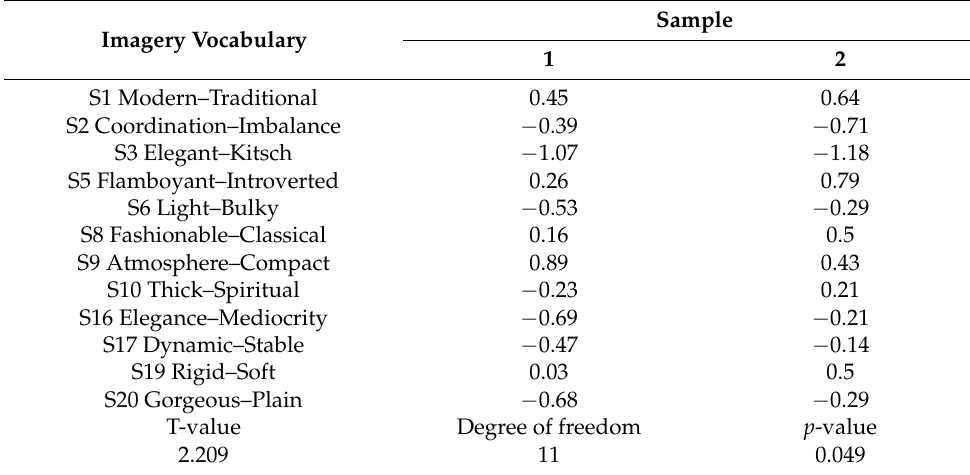
Table 11. Means and p -value test of sample imagery evaluation.